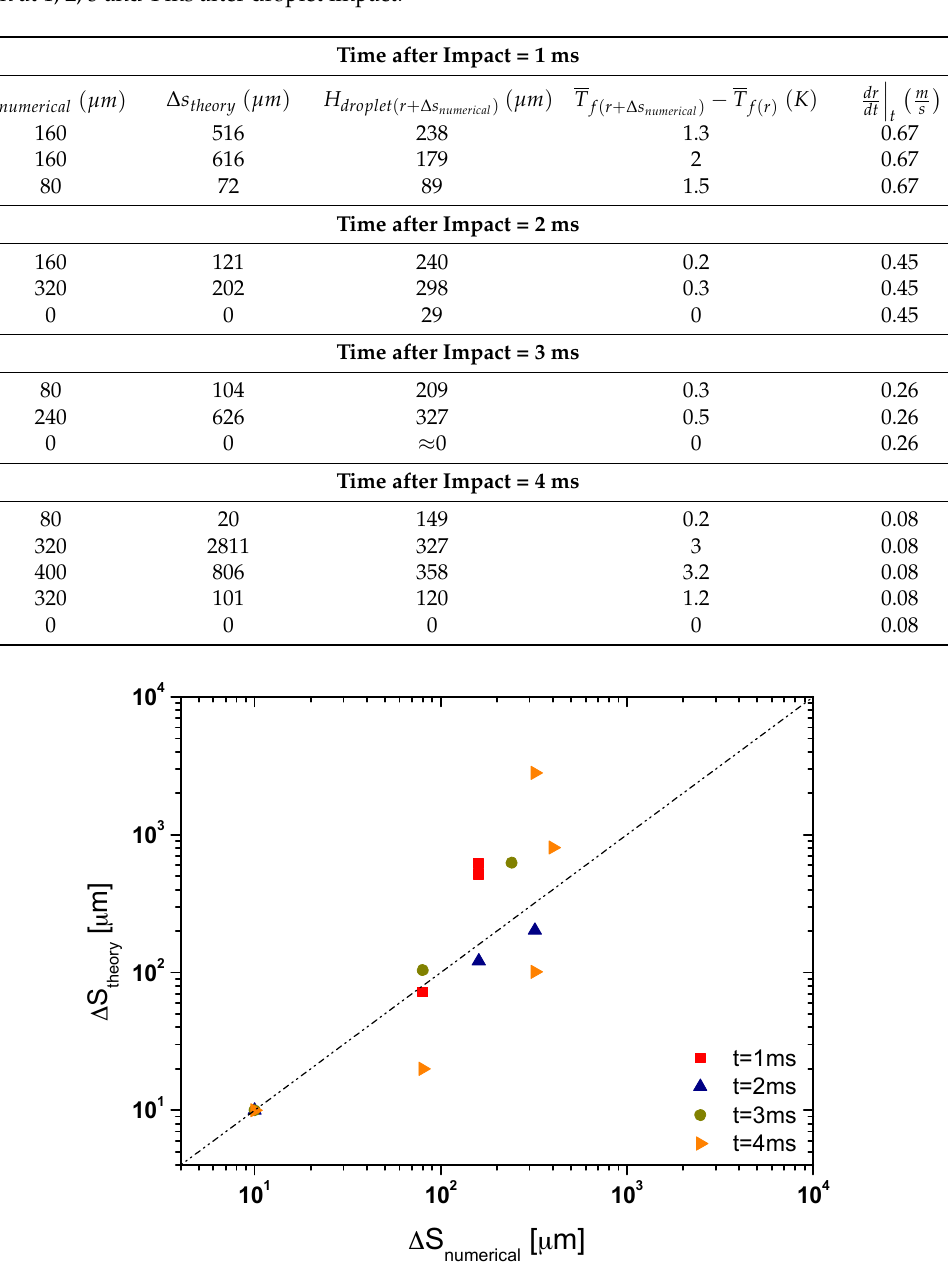
Figure 14. Theoretical versus numerical shifts for time after impact t = 1, 2, 3, 4 ms.